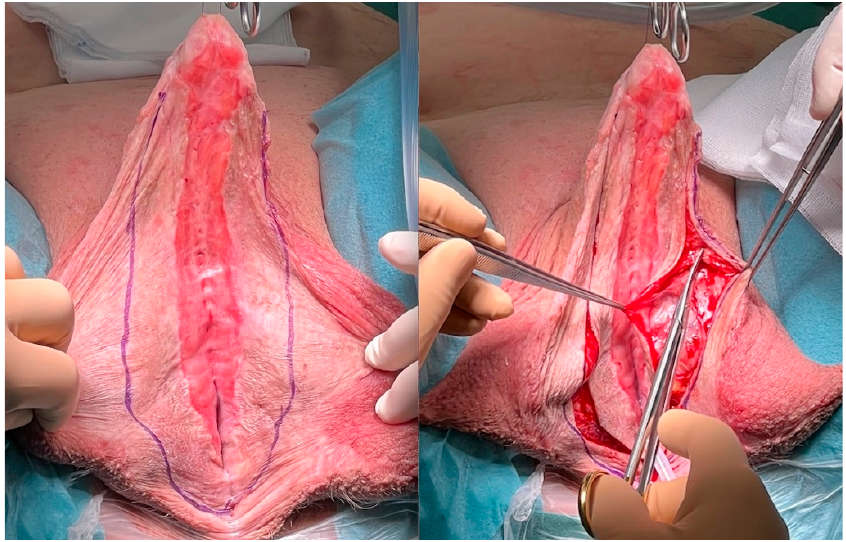
Figure 8. Incising and mobilising the transplanted skin.